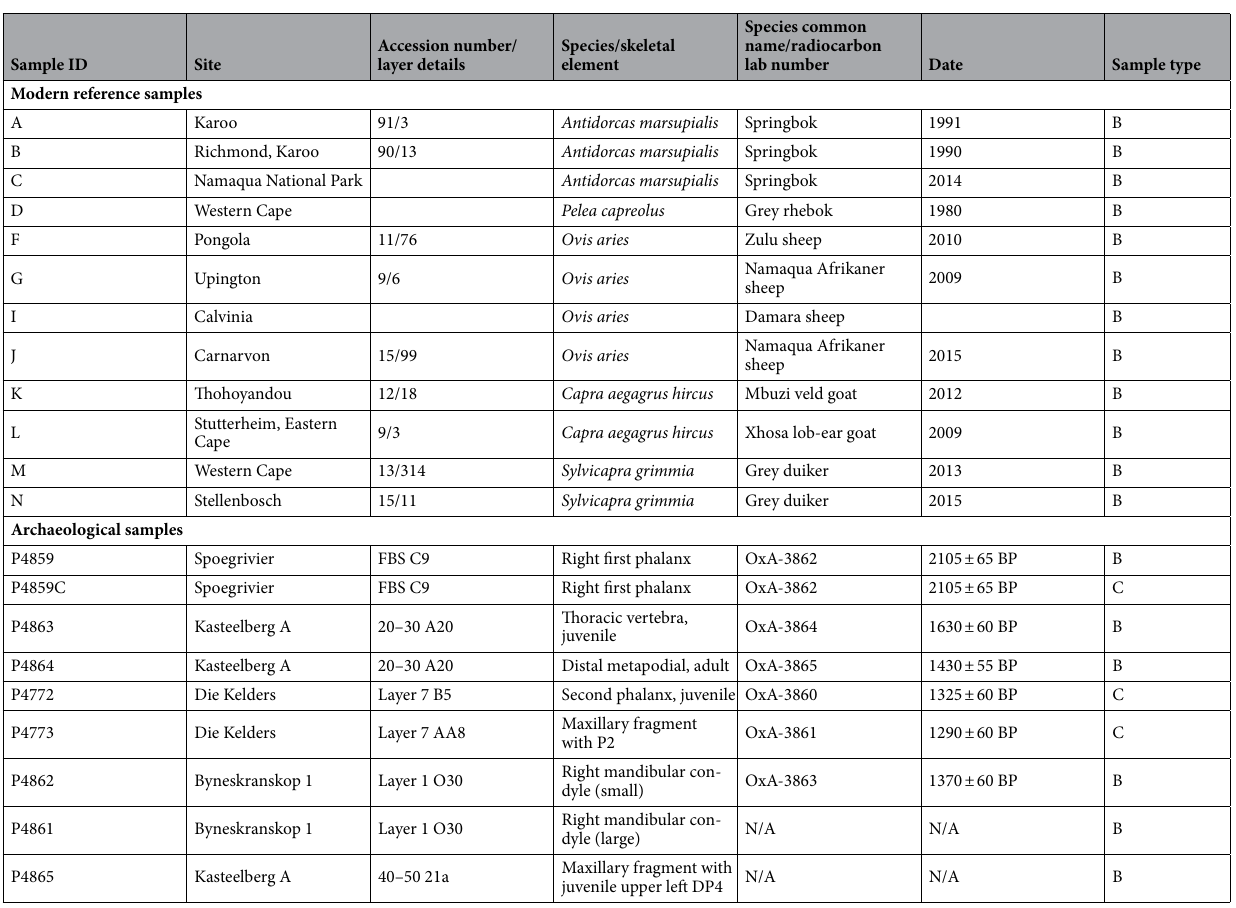
Table 1. Species, provenance, and dates for modern reference and archaeological samples in this study. Radiocarbon dates from Sealy and Yates (1994) 7 . Sample type “B” is bone, “C” is collagen extracted by the Oxford Radiocarbon Accelerator Unit in 1992-3 for AMS dating. Remains of those extracts were returned to us for this study. Date indicates time of death for the modern reference samples, and radiocarbon dates for the archaeological